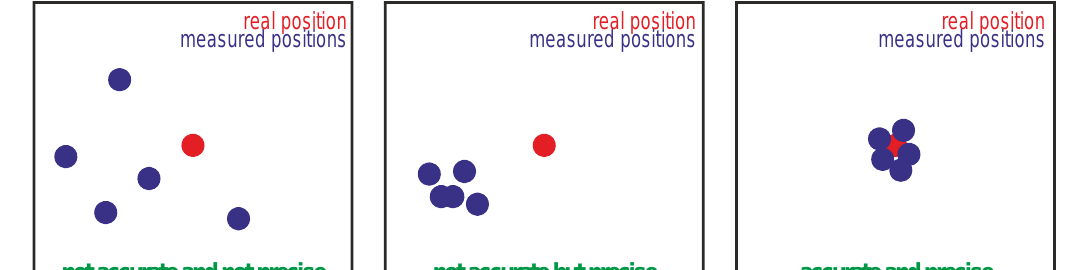
not accurate and not precise not accurate but precise accurate and